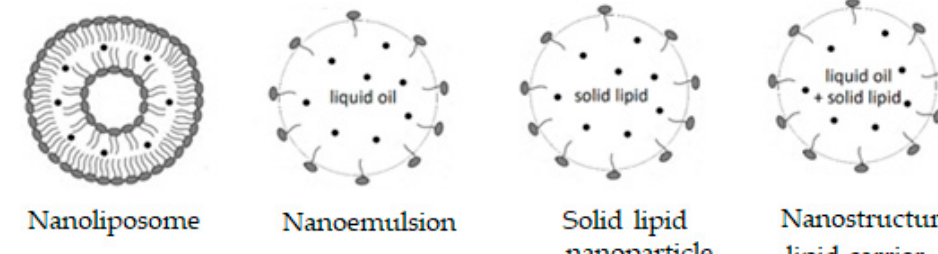
Figure 2. Lipid-based nanocarriers.